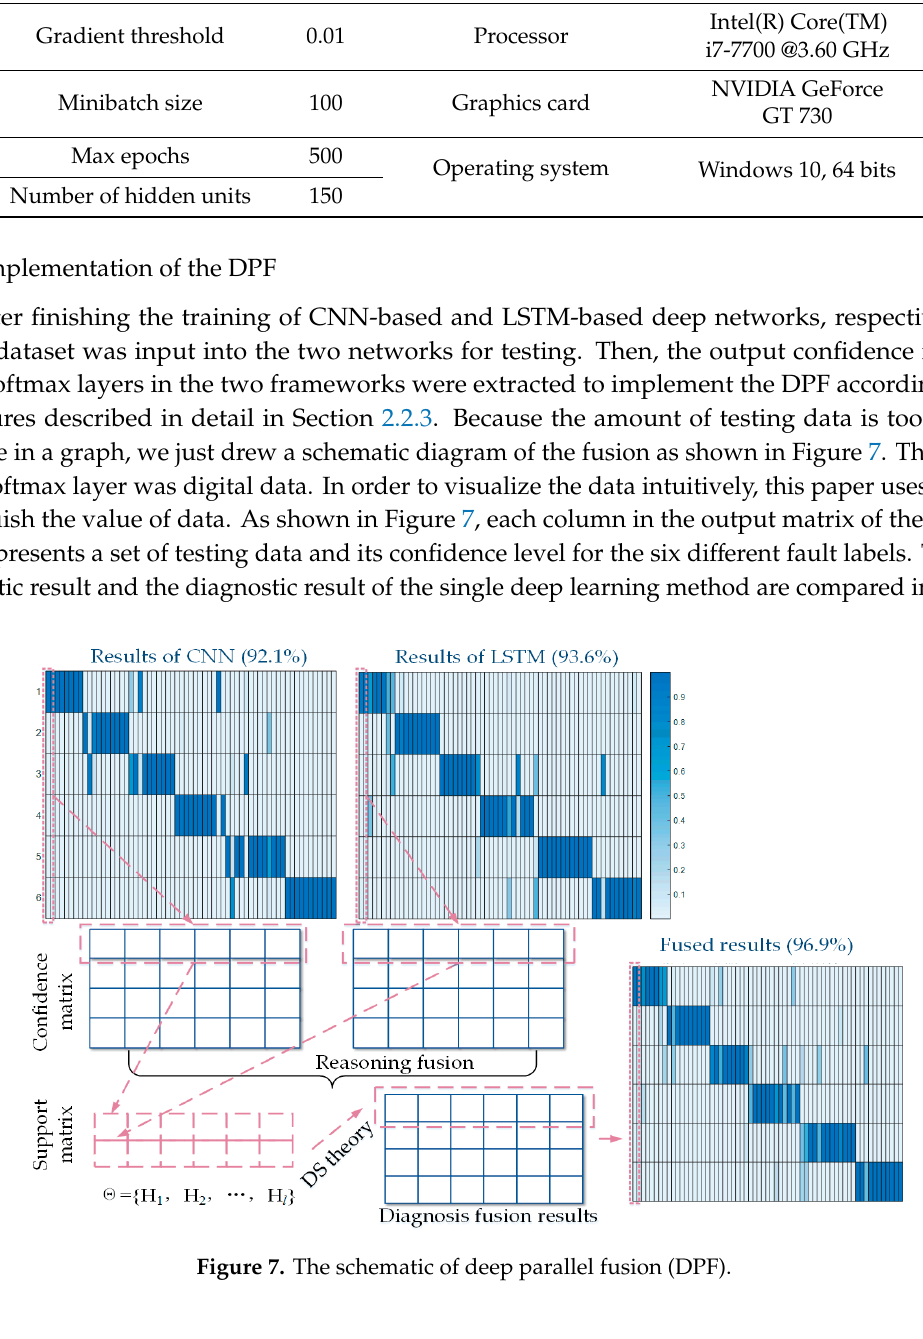
Table 5. The hyperparameters of the LSTM-based network and the computer configuration parameters.